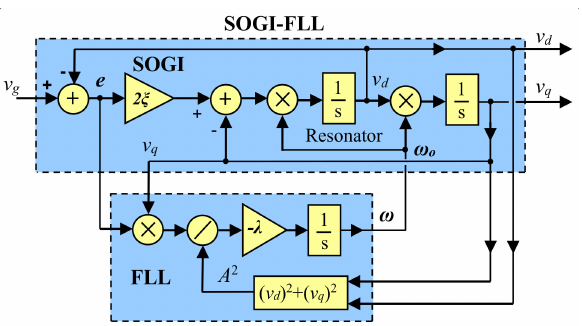
Figure 1. Block diagram of the SOGI-FLL filter.